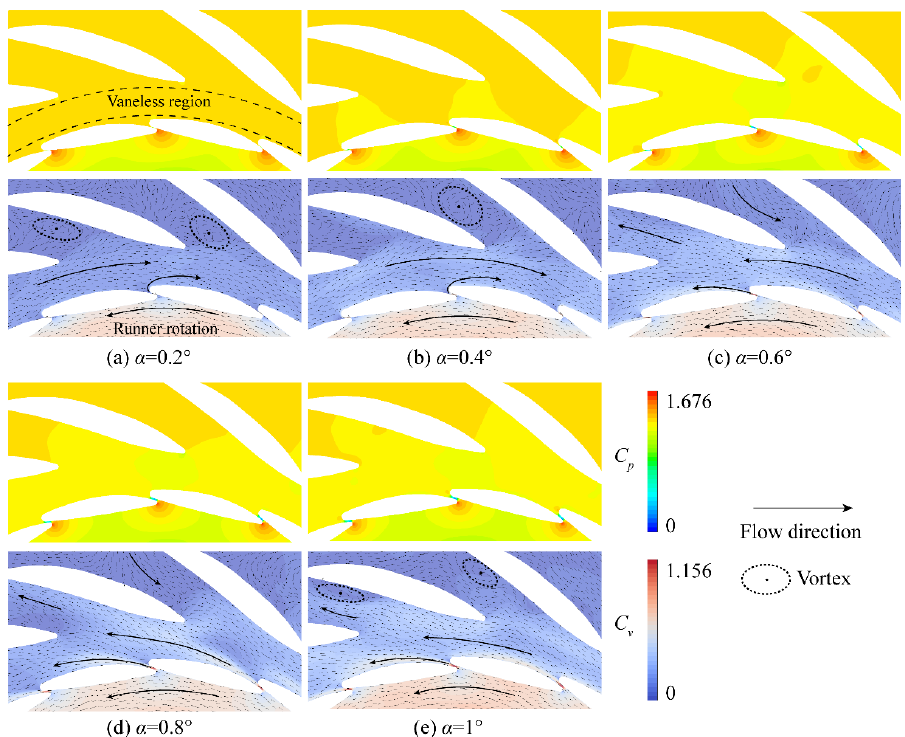
Figure 12. Contours of C p and contours of C v with vectors on the mid-section plane at different opening angles of GV-O under the condition of C ψ = 1.133.